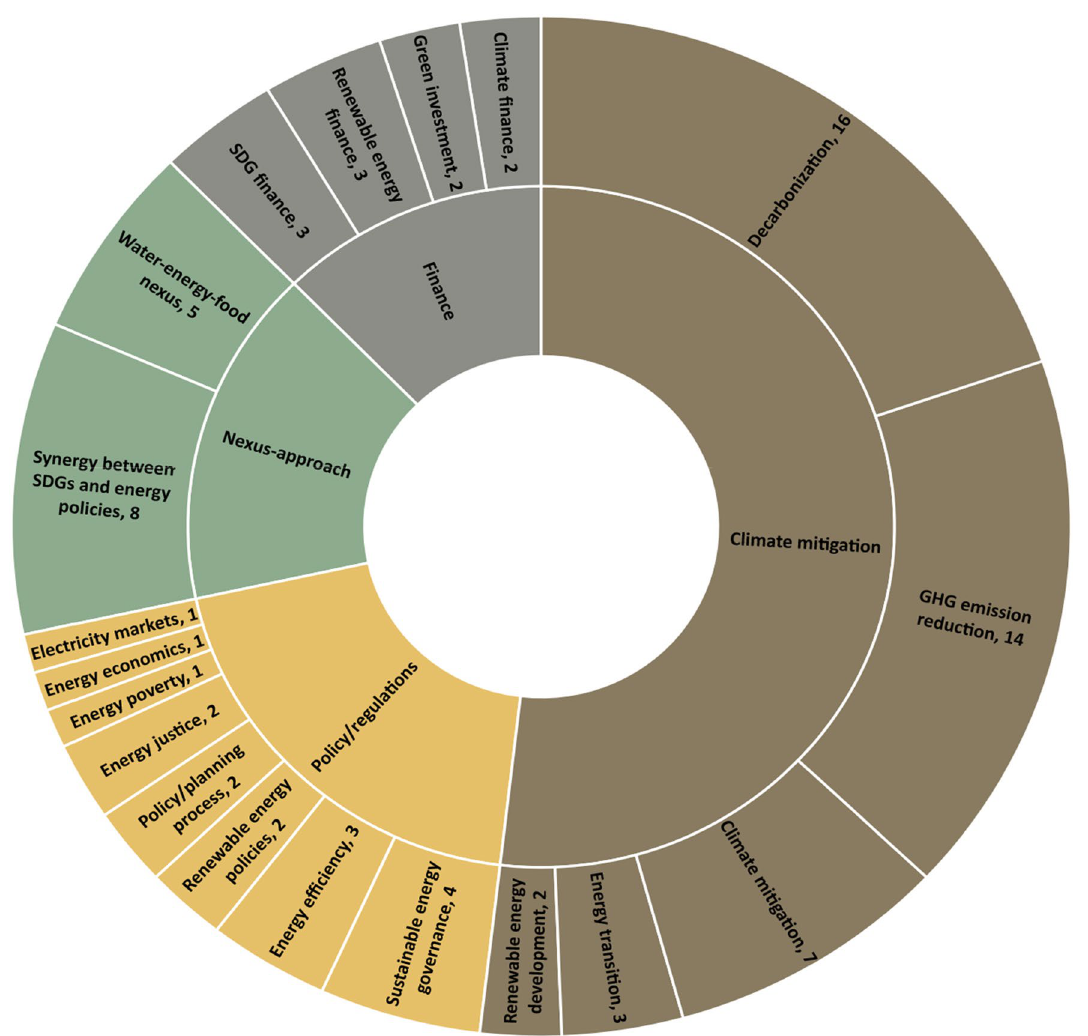
Fig. 7 Emergent themes from the studies reviewed. Source: